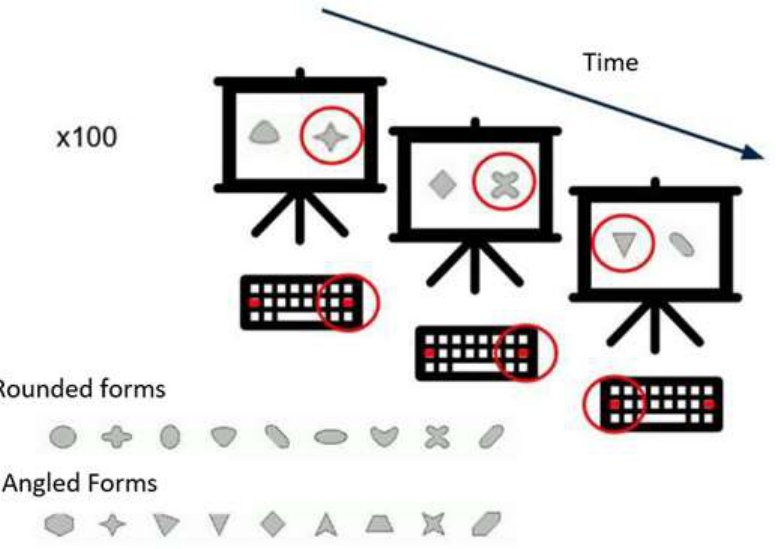
Figure 1. Illustration of the TAP 2.1 Flexibility subtest. The red circle indicates the correct re- sponse.